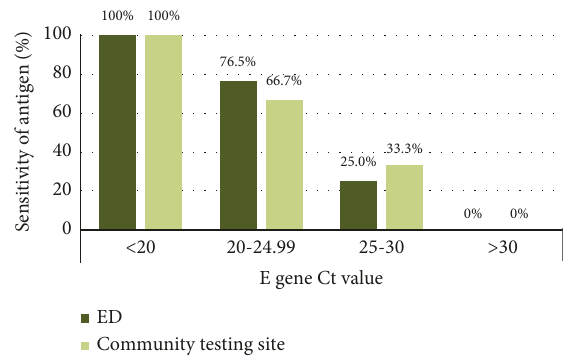
Figure 2: Sensitivity of the VTRUST COVID-19 Antigen Rapid Test with respect to Ct values of RT-PCR for the E gene in the ED and community testing site. RT-PCR, reverse transcription-poly- merase chain reaction; ED, emergency department; Ct cycle threshold; COVID-19: coronavirus disease